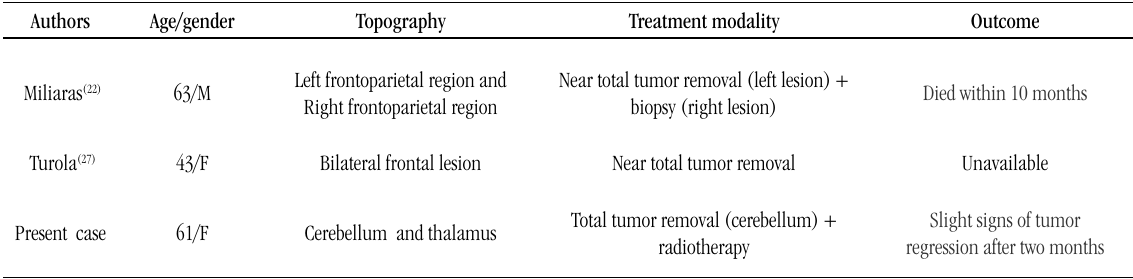
tABLE – Summary of some published cases of multicentric glioblastoma confirmed by histopathological examination